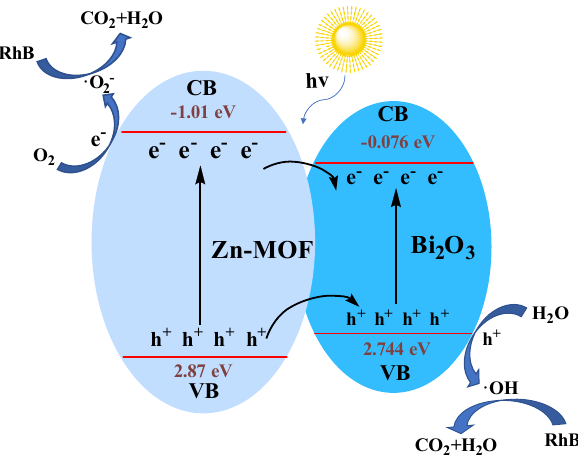
Figure 8: Possible photocatalytic mechanisms of RhB solution using Bi 2 O 3 @Zn - MOF - 2